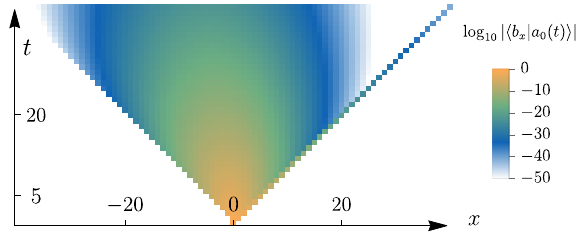
FIG. 1. Correlations between integer sites given by Eq. (38). slowest decay is along j ζ (cid:4) j < 1 . We use defects at all sites ( δ ¼ 1 ) and parameters ε ¼ 0 . 4 , p ¼ q ¼ 1 , a ¼ 0 . 0945626 , and c ¼